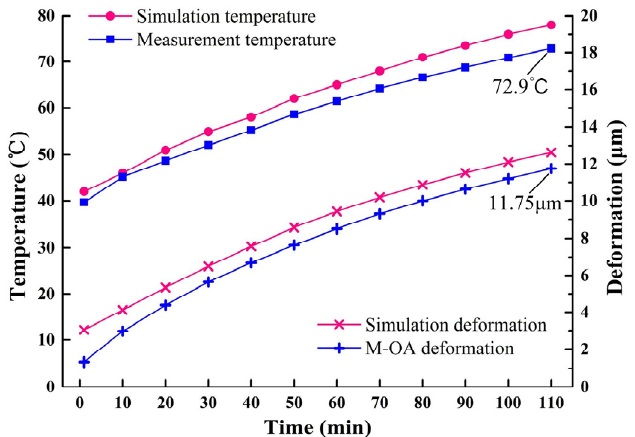
Figure 16. Relationship between the temperature and deformation of the valve orifice when valve opening is 1 mm and inlet pressure is 3 MPa.